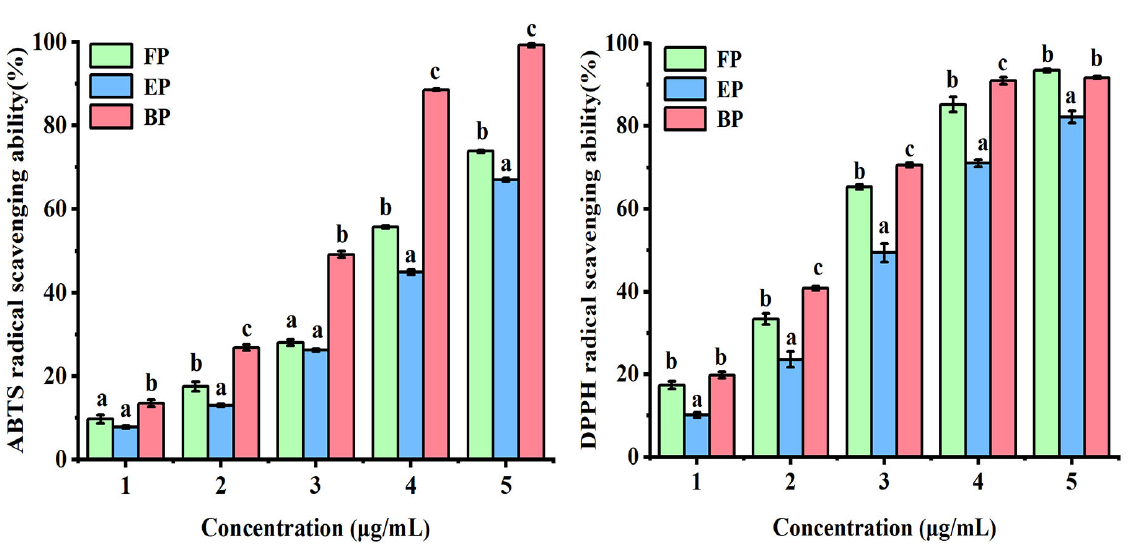
Figure 2. ABTS and DPPH radical scavenging activities of three phenolic fractions from water caltrop ( Trapa quadrispinosa Roxb.) husk. FP, EP and BP means free phenolic, esterified phenolic and insoluble ‐ bound phenolic fractions. All the values are expressed as mean ± SD ( n = 3). The different letters at the same concentration means significant differences ( p < 0.05).